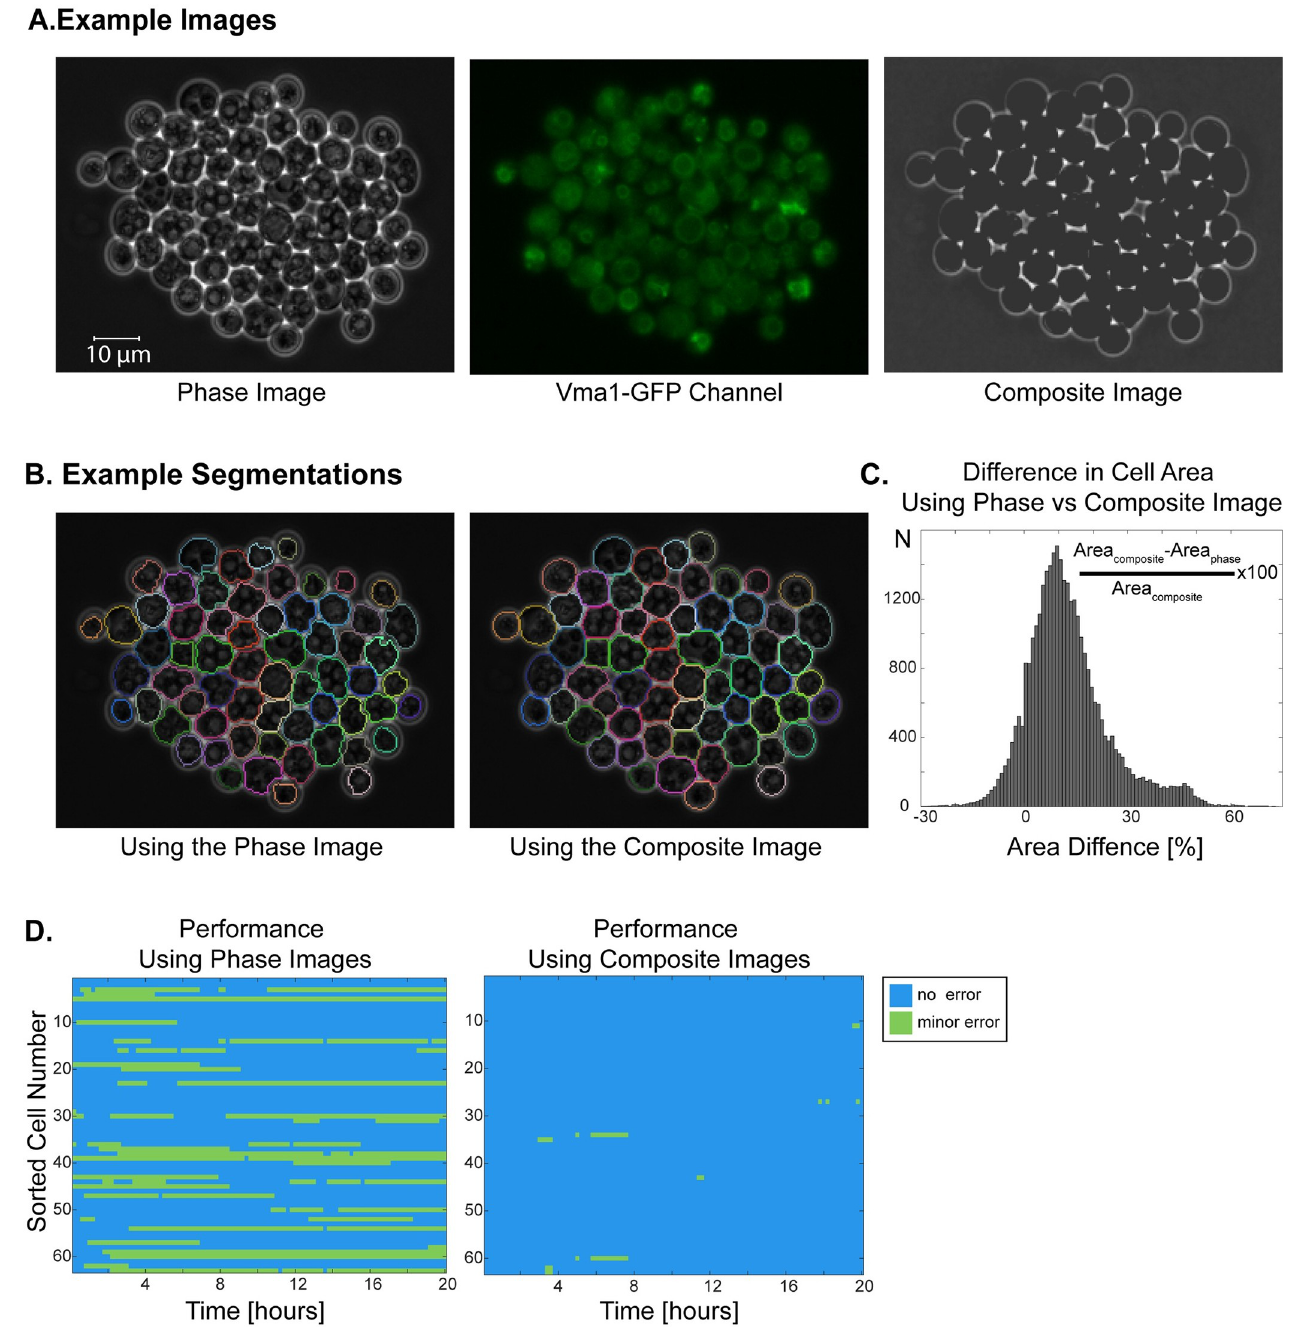
Fig 8. Utilizing a fluorescent channel for improving the segmentation of sporulating cells. (A) Example phase image, GFP-channel image and the composite image. In the phase image, spores have very bright patches unlike cycling cells. The composite image is created using the phase and GFP-channel images. Note that Vma1-GFP channel is not dedicated to segmentation. (B) Segmentation results using the phase image and using the composite image. Using the composite image corrects for the slight out of focus phase image and significantly improves the segmentation. (C-D) Comparison of segmentations with phase and composite images. Example cells were imaged for 20 hours (100 time points) and segmented with phase or the composite images. (C) Out of 32868 cell segmentation events, 89.5% of them have a greater area when the composite image is used for segmentation. (D) Comparison of errors in segmentation with phase or composite images. Blue no error, green minor error. Minor errors decreased significantly when composite images were used for